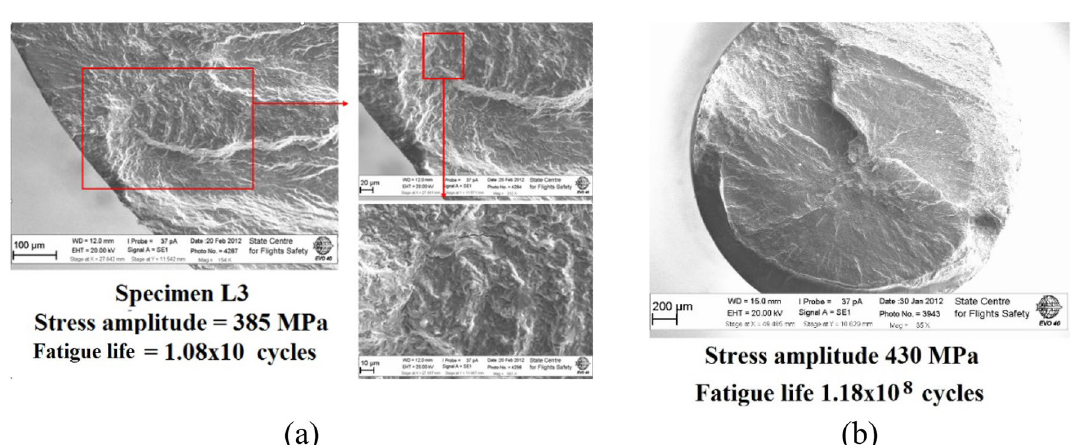
Fig. 8 Examples of subsurface initiation of a fatigue crack in titanium alloy VT3-1 from an existing microstructure defect in the form of mac- rozone boundary ( a ) and from a formed concentrator in the form of smooth facet ( b